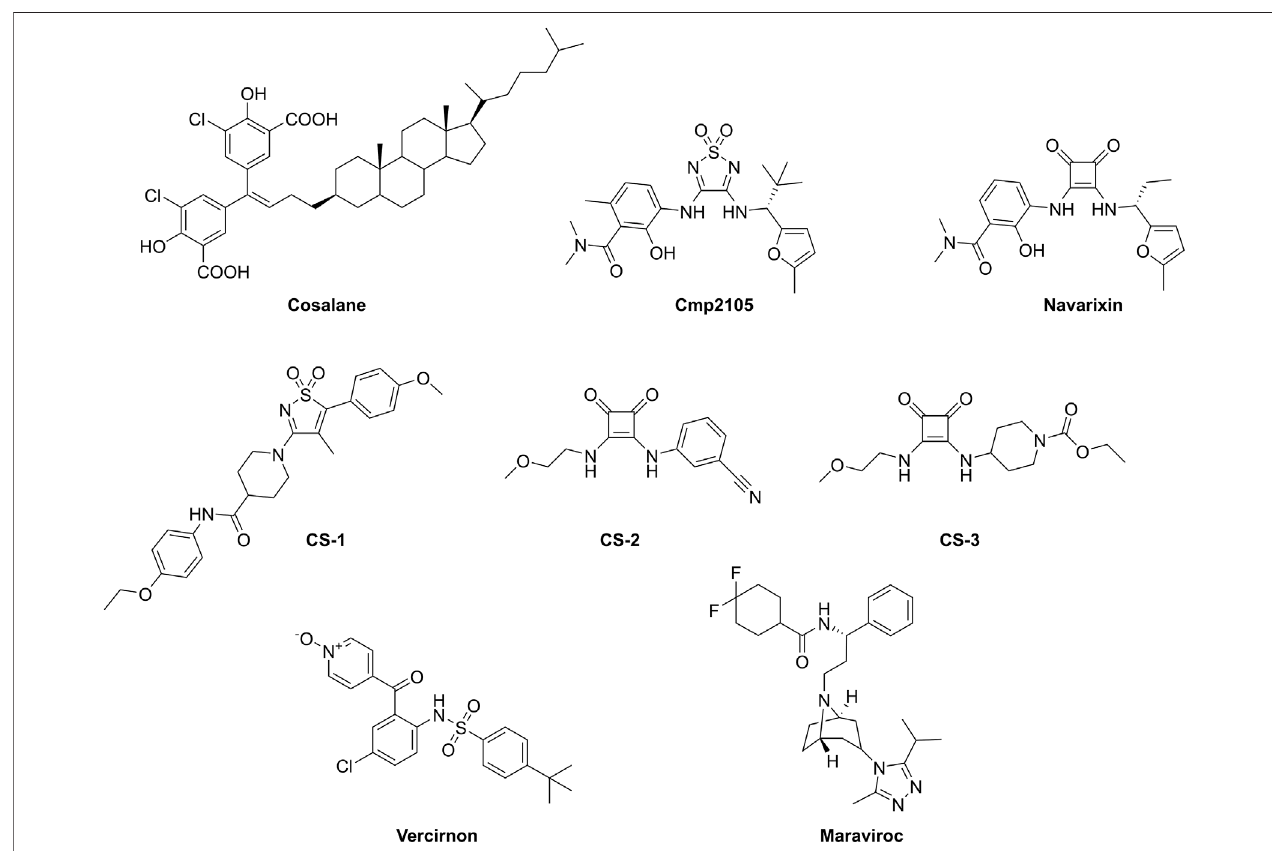
FIGURE 1 | Compounds studied as CCR7